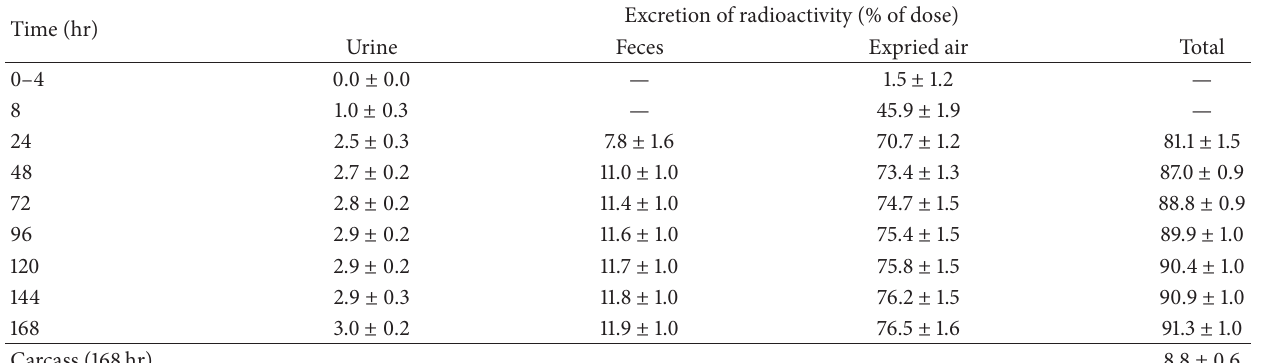
Table 2: Cumulative excretion of radioactivity in urine, feces, and expired air as 14 CO to rats (dose: 25